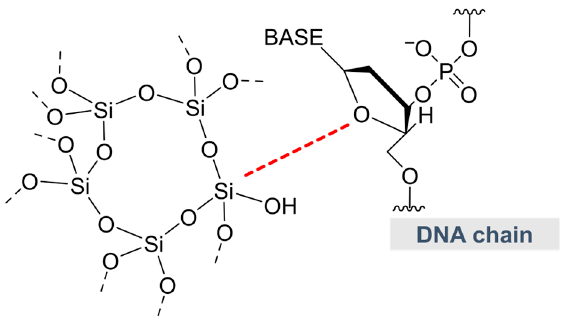
Figure 7. One of many Si-O interactions (dotted line in red) between SNP and DNA strand. Color image available online.